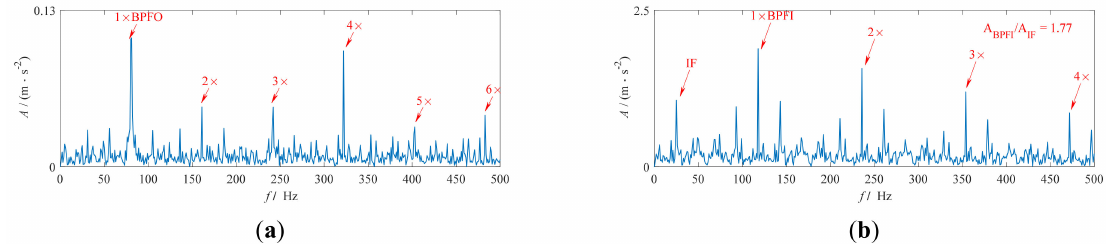
Figure 9. SES of the results from RVMD: ( a ) corresponds to the result shown in Figure 8b; ( b ) corresponds to the result shown in Figure